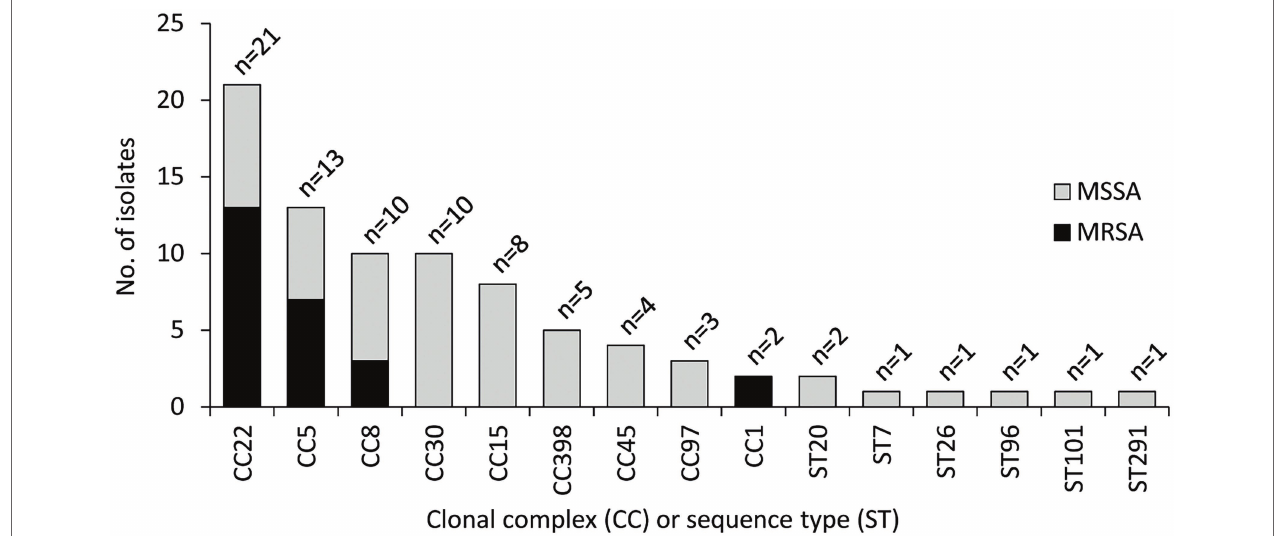
FIGURE 1 | Clonal complex (CC) and sequence type (ST) distribution of 83 Staphylococcus aureus isolates from OM. CC22 (ST22, n = 20; ST3863, n = 1), CC5 (ST5, n = 9; ST105, n = 2; ST228, n = 2), CC8 (ST8, n = 7; ST72, n = 1; ST368, n = 1; ST789, n = 1), CC30 (ST30, n = 7; ST34, n = 1; ST4391, n = 1; ST7297, n = 1), CC15 (ST15, n = 5; ST582, n = 3), CC398 (ST398, n = 5), CC45 (ST45, n = 4), CC97 (ST97, n = 3), CC1 (ST1, n = 1; ST6927, n = 1), ST20 ( n = 2), ST7 ( n = 1), ST26 ( n = 1), ST96 ( n = 1), and ST101 ( n =